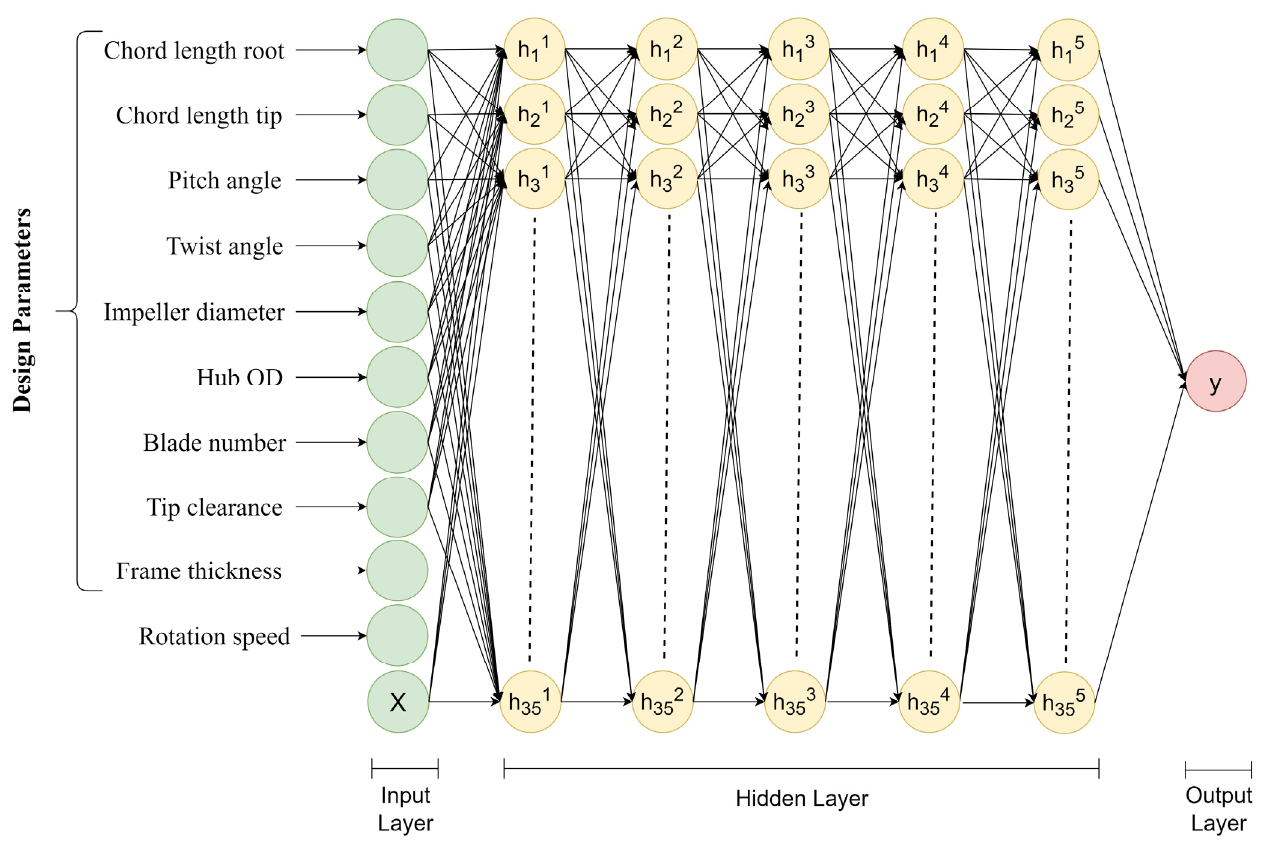
Figure 2. DNN architecture diagram [13].